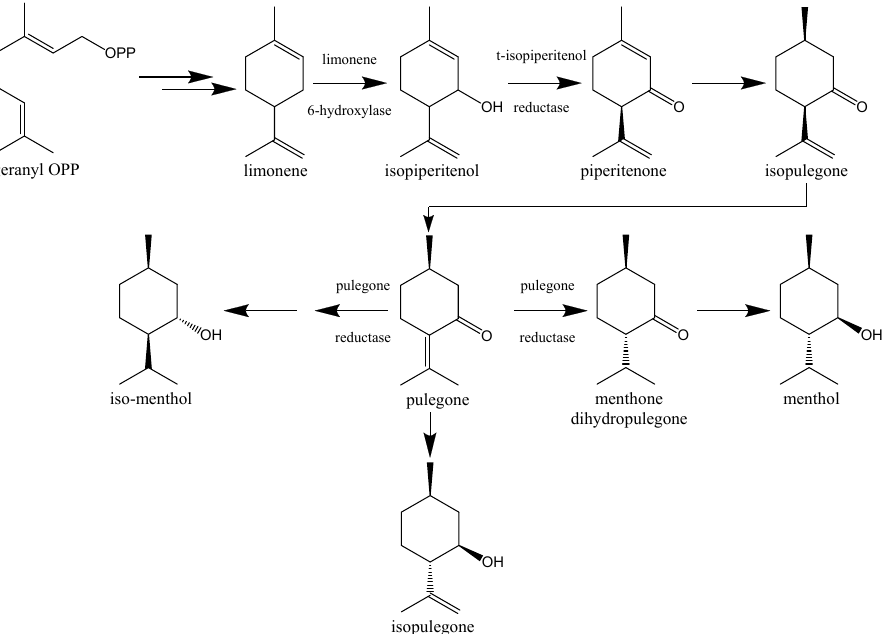
Scheme 1. Biosynthetic pathway for PUL and its reduced forms [217].